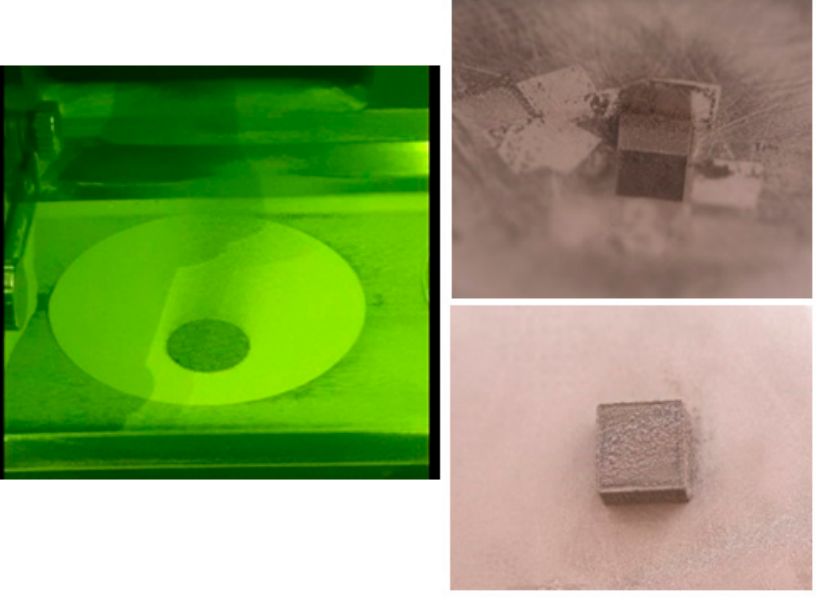
Figure 3. Video capture during L-PBF process ( left ). Two samples of L-PBF-processed Mg-10Zn- 0.8Ca-0.5Zr powder alloy ( right ).